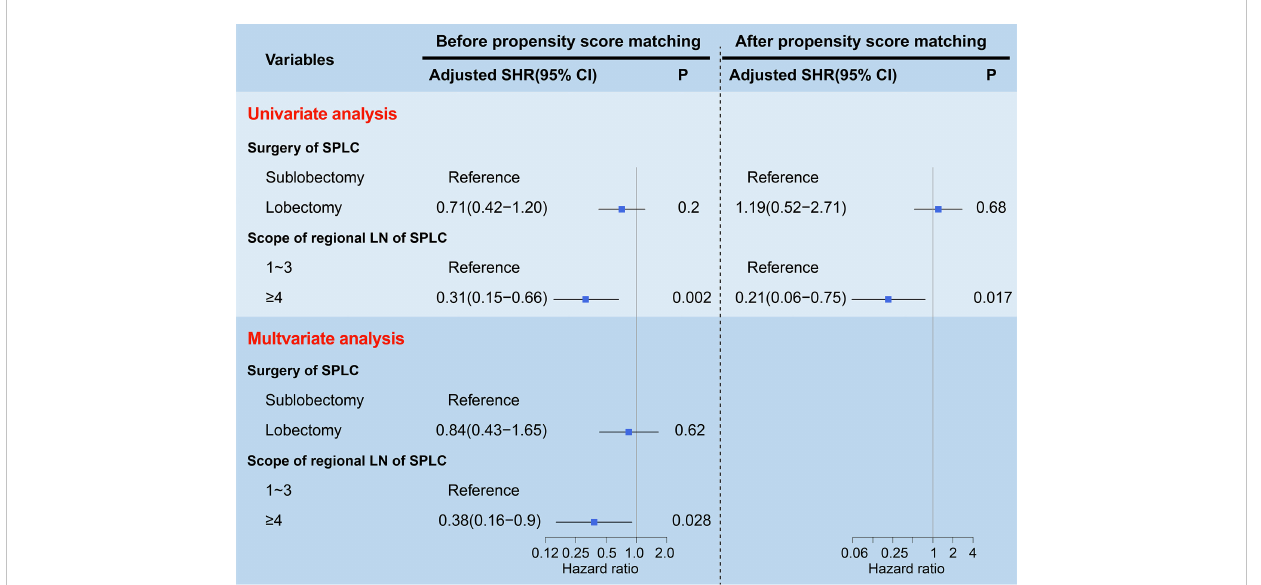
FIGURE 5 Forest plots visualizing the SHRs and P-values of the predictors (surgery and scope of regional LN) using the univariate and multivariate competing risk models before and after propensity score matching. The gray vertical solid line indicates SHR of 1. LN, lymph node; SP, second primary non- small cell lung cancer; SHR, subdistribution hazard ratio; CI, con fi dence